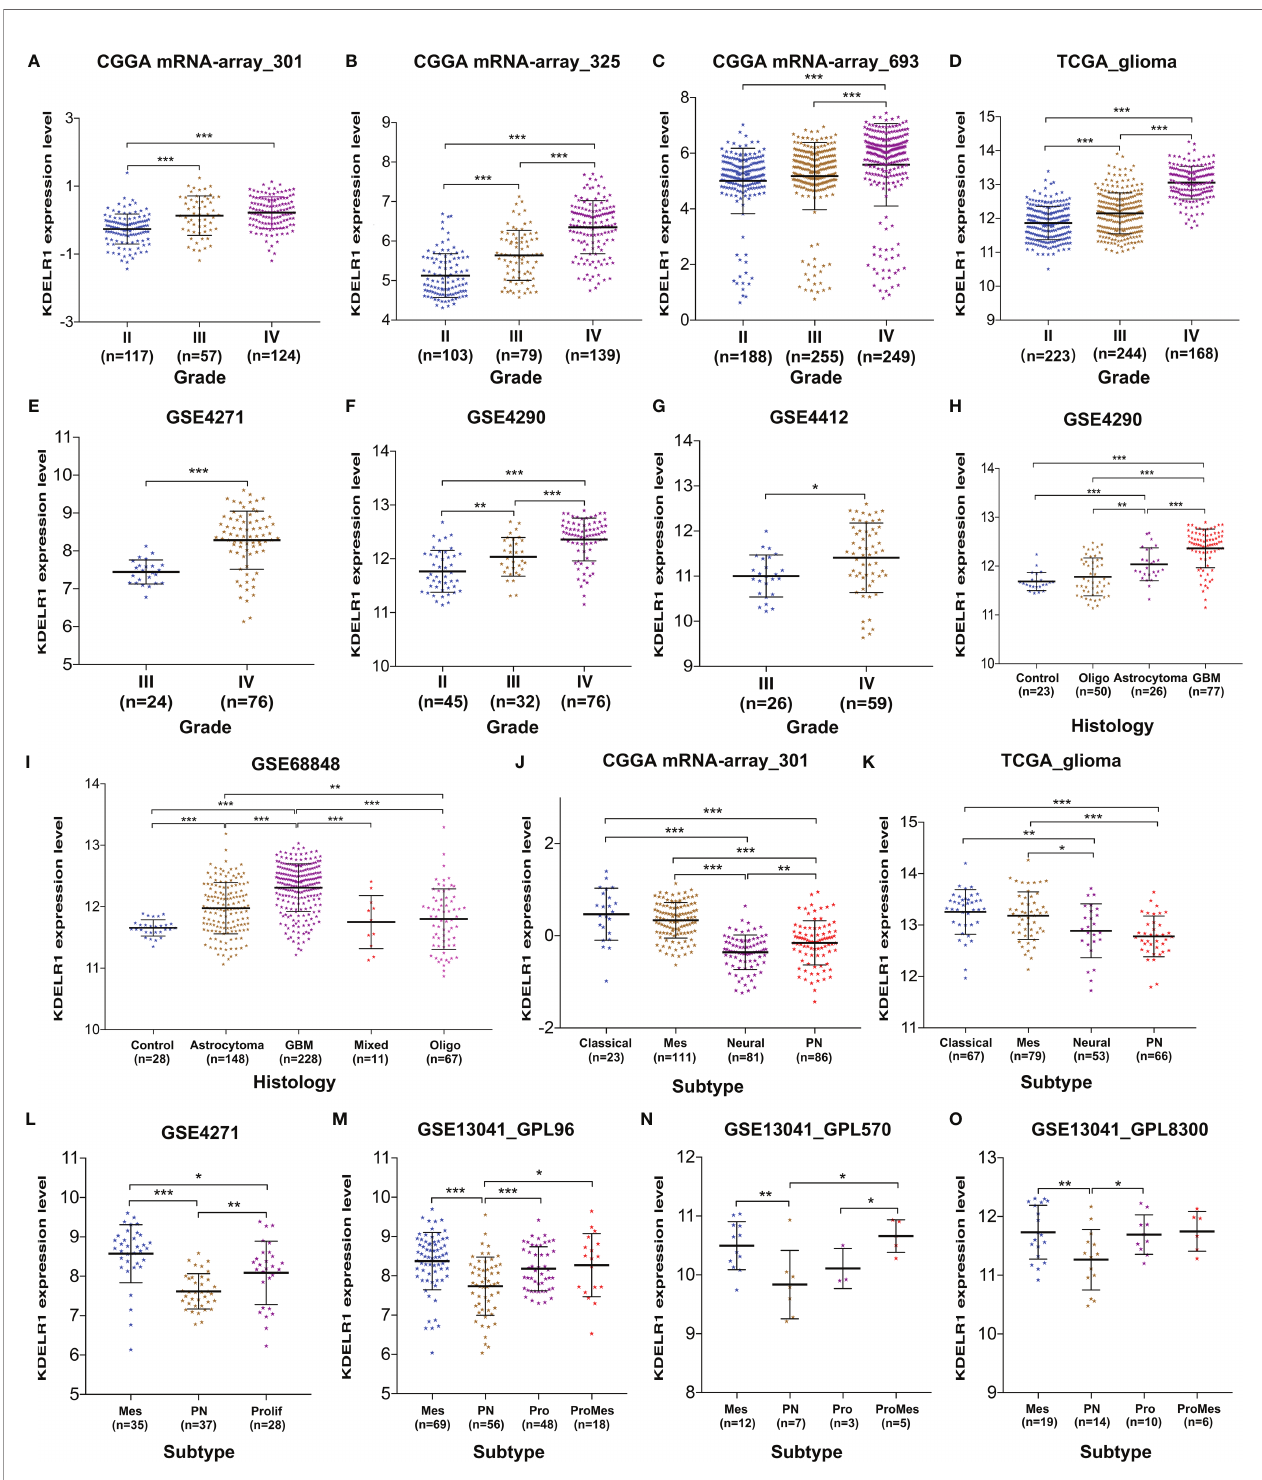
FIGURE 4 | The associations between KDELR1 expression, and the WHO grades, histology, and molecular classi fi cation of gliomas. (A – G) KDELR1 expression signi fi cantly increased as the WHO grades of gliomas, including mRNA-array_301, mRNA-array_325, and mRNA-array_693 of CGGA, TCGA_glioma, GSE4271, GSE4290, and GSE4412. (H) Expression level of KDELR1 was gradually upregulated in the order of control, oligodendrogliomas, astrocytomas, and GBMs in GSE4290. (I) KDELR1 expression was upregulated in the order of control, oligodendrogliomas, astrocytomas, and GBMs in the dataset GSE68848. (J – O) Distribution of KDELR1 expression among distinct classi fi cation subtypes of gliomas in different datasets, including CGGA mRNA-array_301, TCGA_glioma, GSE4271, GSE4290, and GSE13041 (GPL96, GPL570, and GPL8300). *P < 0.05; **P < 0.01; ***P <